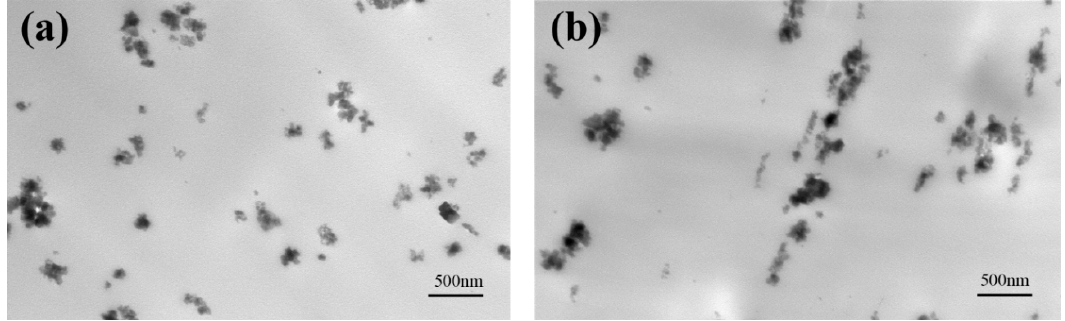
Figure 1. TEM graphs of the PA612/SiO 2 films at the strain of ( a ) ε = 0 and ( b ) ε = 2.